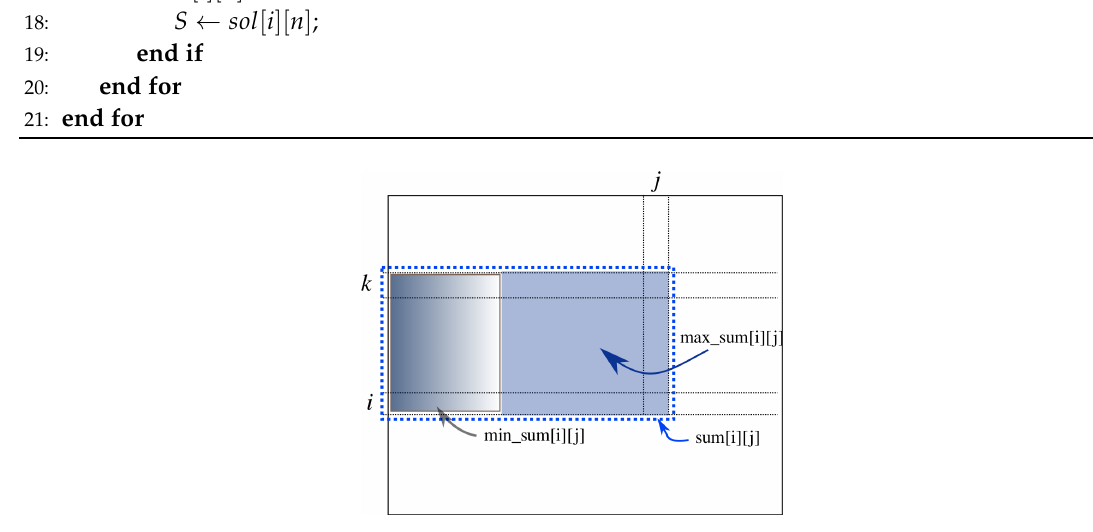
Figure 3. Strip-based sequential